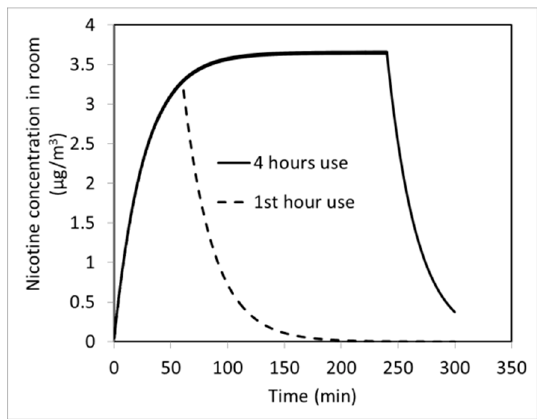
Figure 9. Model predictions for exposure chamber nicotine concentration for 4 h use of e-cigarettes compared with 1 h use.